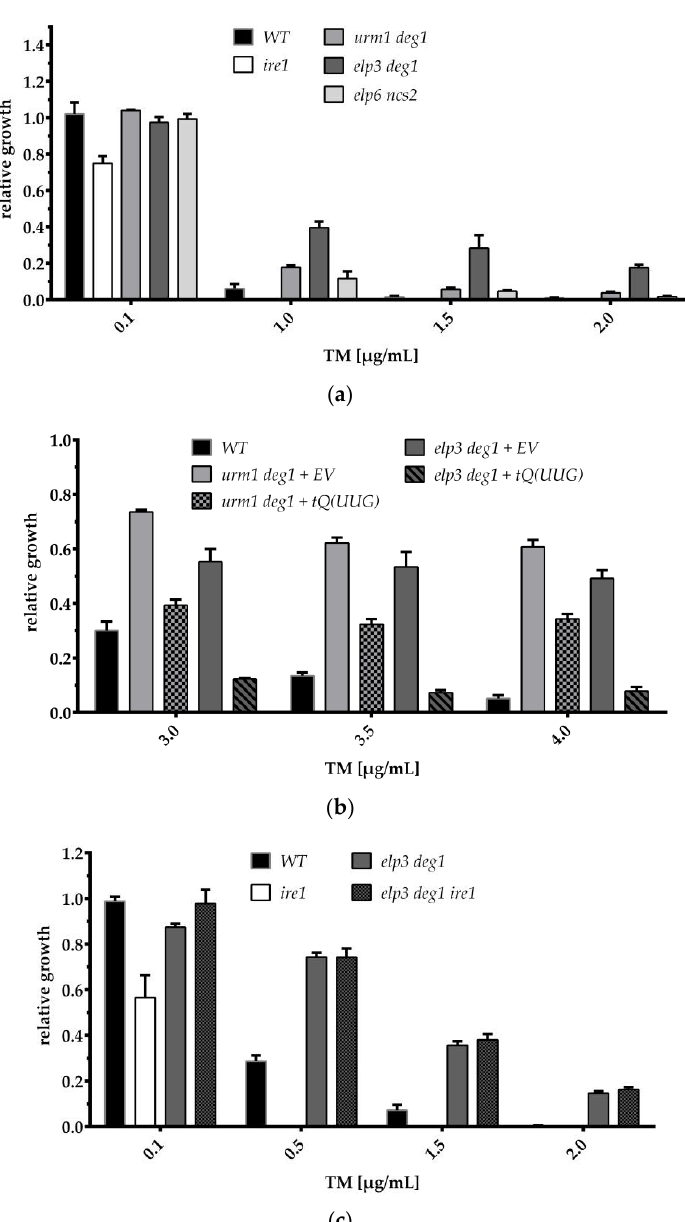
Figure 3. TM phenotypes of tRNA modification mutants and their response to tRNA Gln (UUG) overexpression. The indicated yeast strains were cultivated in YPD ( a , c ) or in YNB ( b ) 24 h with indicated concentrations of TM. Each experiment involved three biological replicates, and the resulting standard deviations are indicated on the bars. EV: empty vector; tQUUG : tRNA Gln (UUG) expressing vector.